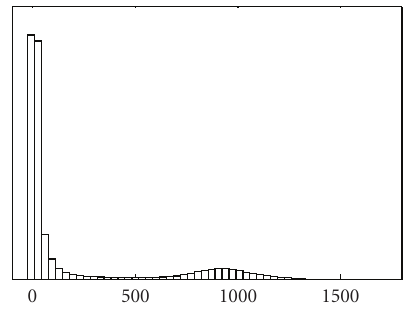
Figure 5: Histogram of the time series mean image of TS 1